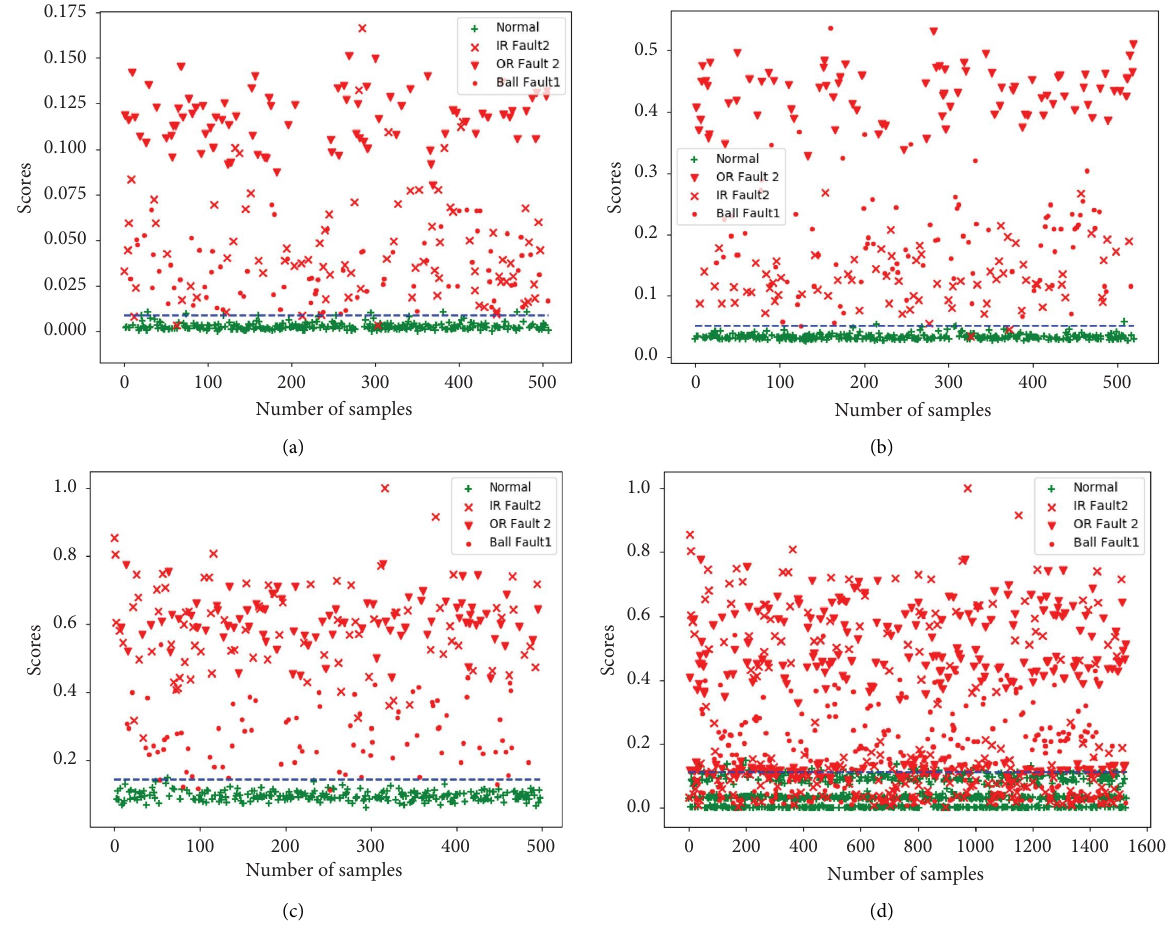
Figure 9: Anomaly detection by MW-CVAE and